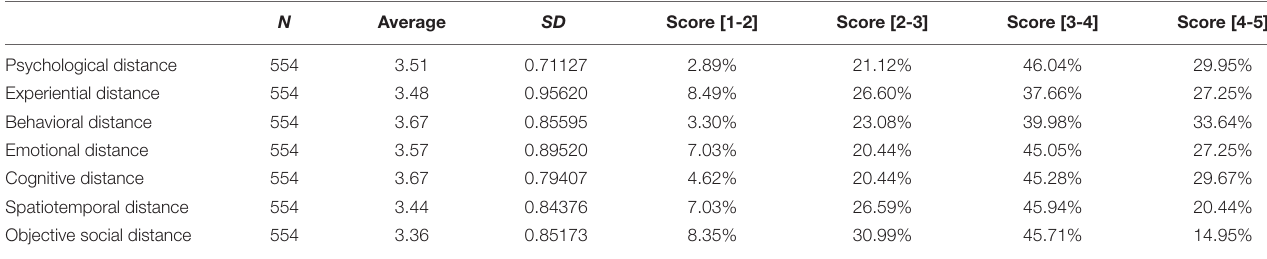
TABLE 3 | Descriptive statistical analysis results of